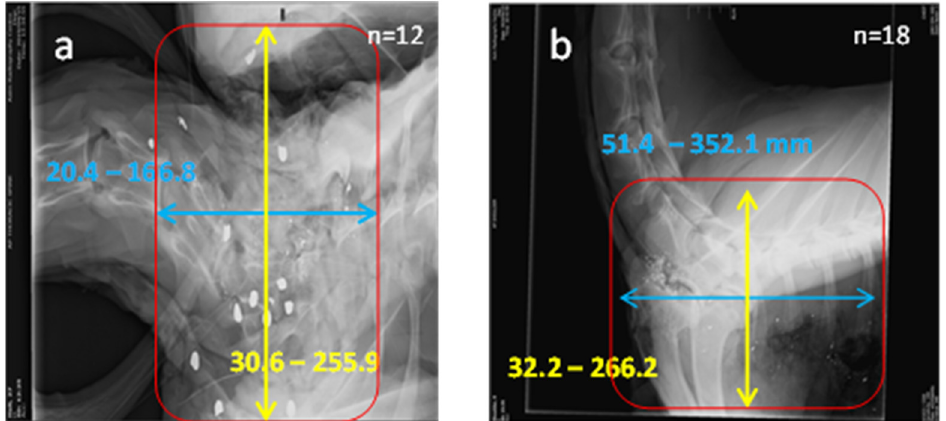
Figure 5. The affected surface of carcasses from the two killing methods. ( a ) Typical helicopter kill showing pellets’ dispersion ranges (mm) from top to bottom/vertical and sideways/horizontal of the carcasses ( b ) and bullet particles’ dispersion ranges (mm) from top to bottom/vertical and sideways/horizontal for a typical rifle shot kill.